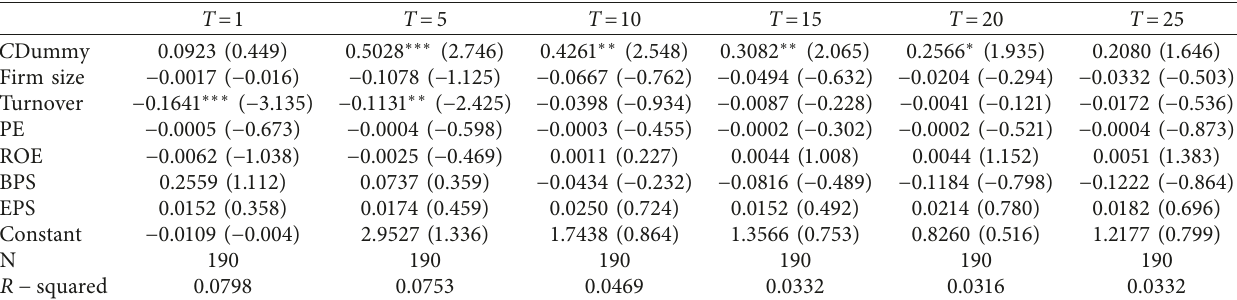
Table 5: Regression result of model (4): excessive trading volume and registered place of listed company. T �